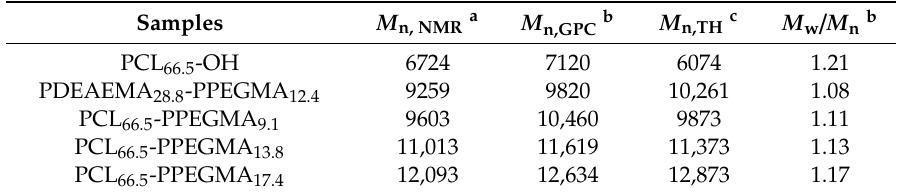
Table 1. GPC and 1 H NMR results of polymeric